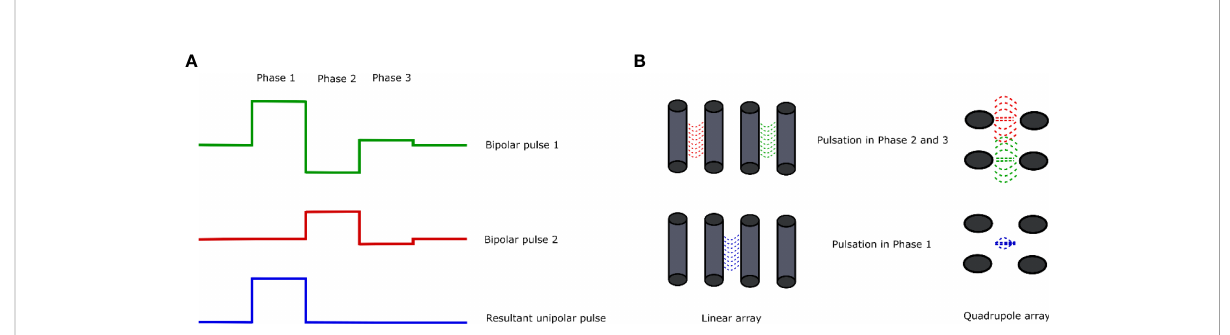
FIGURE 4 Overview of the CANCAN effect. (A) Summation of the bipolar pulses results in the formation of a unipolar pulse with the resultant pulse in Phase 1. (B) Two arrangements of electrodes for the study of the CANCAN effect and the effects of pulsation in each of the phases. The left side shows the linear arrangement of the needle electrodes; on the right side, the needle electrodes are arranged in a square — in each case, the distance between the neighboring needles remains